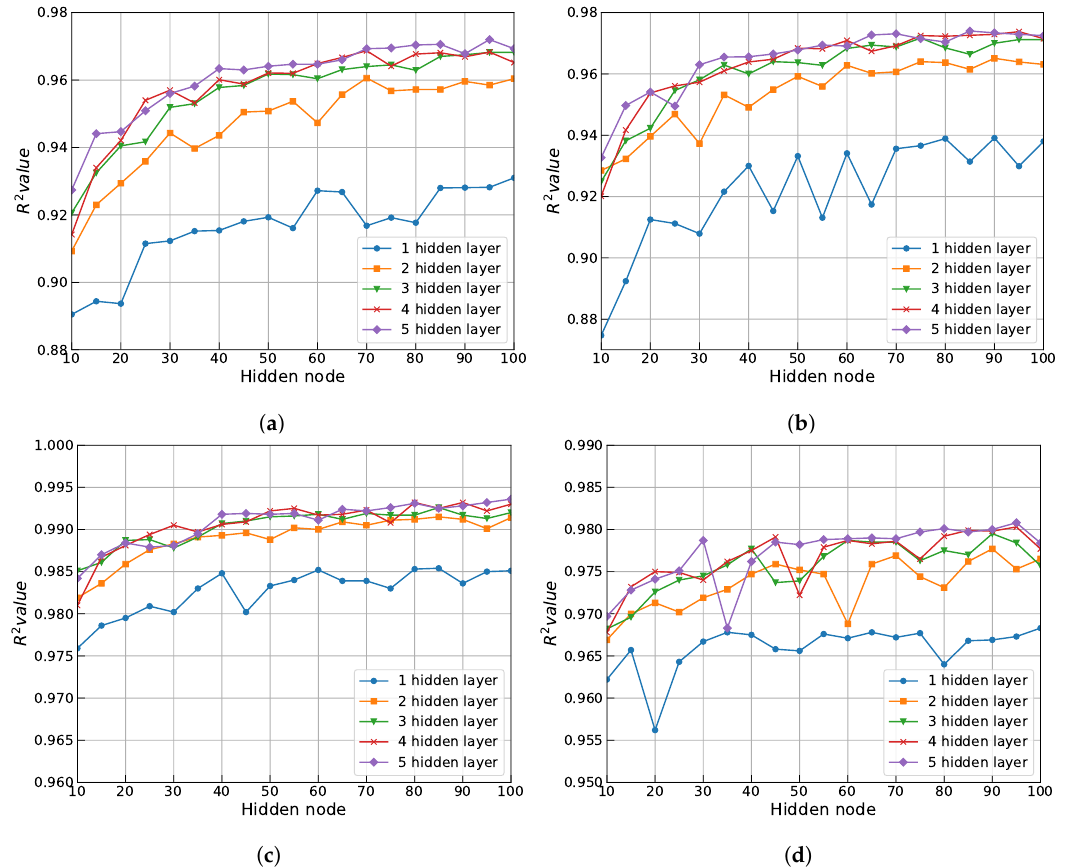
Figure 7. Effect of changing the number of hidden neurons and layers on R 2 : ( a ) Case 3, ( b ) Case 4, ( c ) Case 7, and ( d ) Case